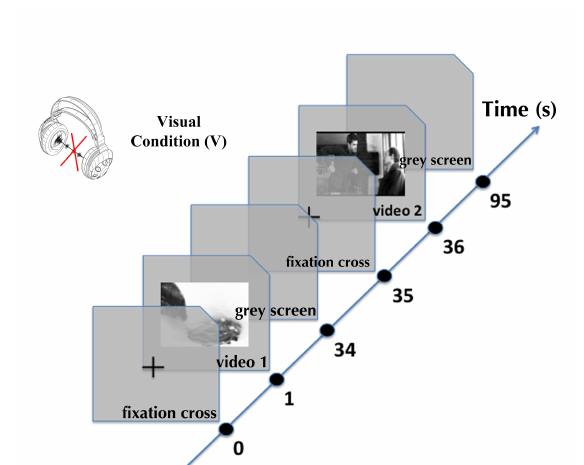
Figure 1 . Time course of two trials in the visual condition. To control the gaze of observer, a fixation cross is presented at the center of the screen. Then, a video sequence is pre- sented in the center, followed by a grey screen. This sequence is repeated for the 50 videos, one block of 25 videos without sound (Visual condition) and the other block with their orig- inal soundtracks (Audio-Visual